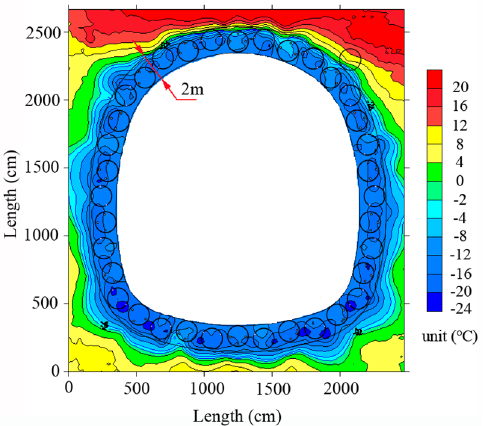
Figure 14 . Temperature field of actual construction condition. Figure 14. Temperature field of actual construction